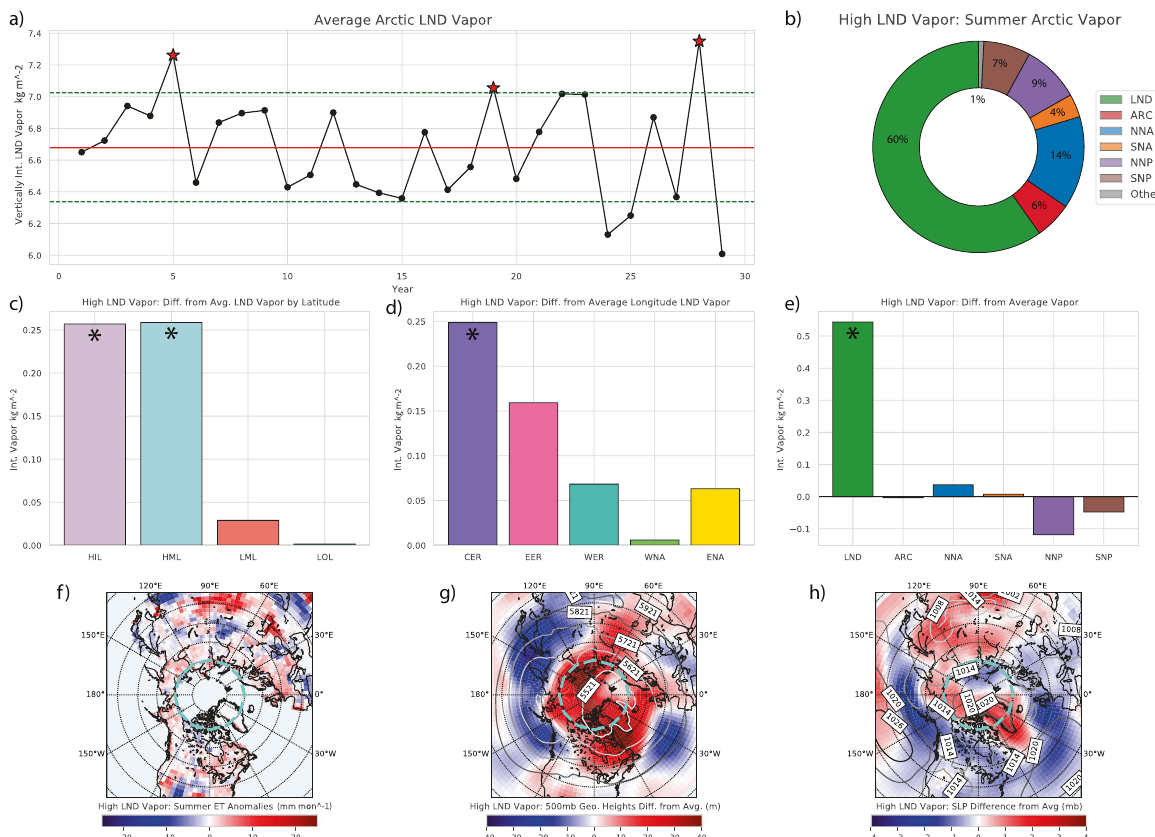
Fig. 9 Conditions associated with the largest positive anomalies of land vapor in the Arctic. a Average summer land vapor in the Arctic for each year of the simulation. The red stars denote anomalously high land vapor years used in panels b – h . b The percent contribution to total Arctic vapor from land and individual ocean regions in anomalously high land vapor summers. c The anomalies in land vapor contributions from latitude-based regions during high Arctic land vapor summers. d The anomalies in land vapor contributions from longitude-based regions during high Arctic land vapor summers. e The anomalies in vapor contributions from land and individual ocean regions during high Arctic land vapor summers. f The anomalies in ET during high Arctic land vapor summers. g The average 500 mb GPH fi elds (contours) and difference from climatological mean (shading) during high Arctic land vapor summers. h The average SLP fi elds (contours) and difference from climatological mean (shading) during high Arctic land vapor summers. Asterisks on the bars in c – e indicate statistically signi fi cant anomalies (see